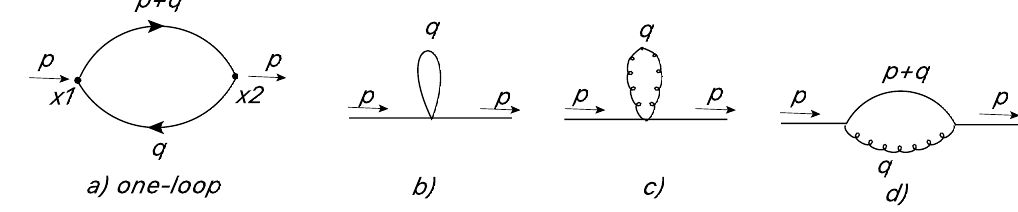
Figure 1 . One-loop diagrams: a) Unique one-loop diagram for the two-point function of currents. b), c), d) one-loop counterterm